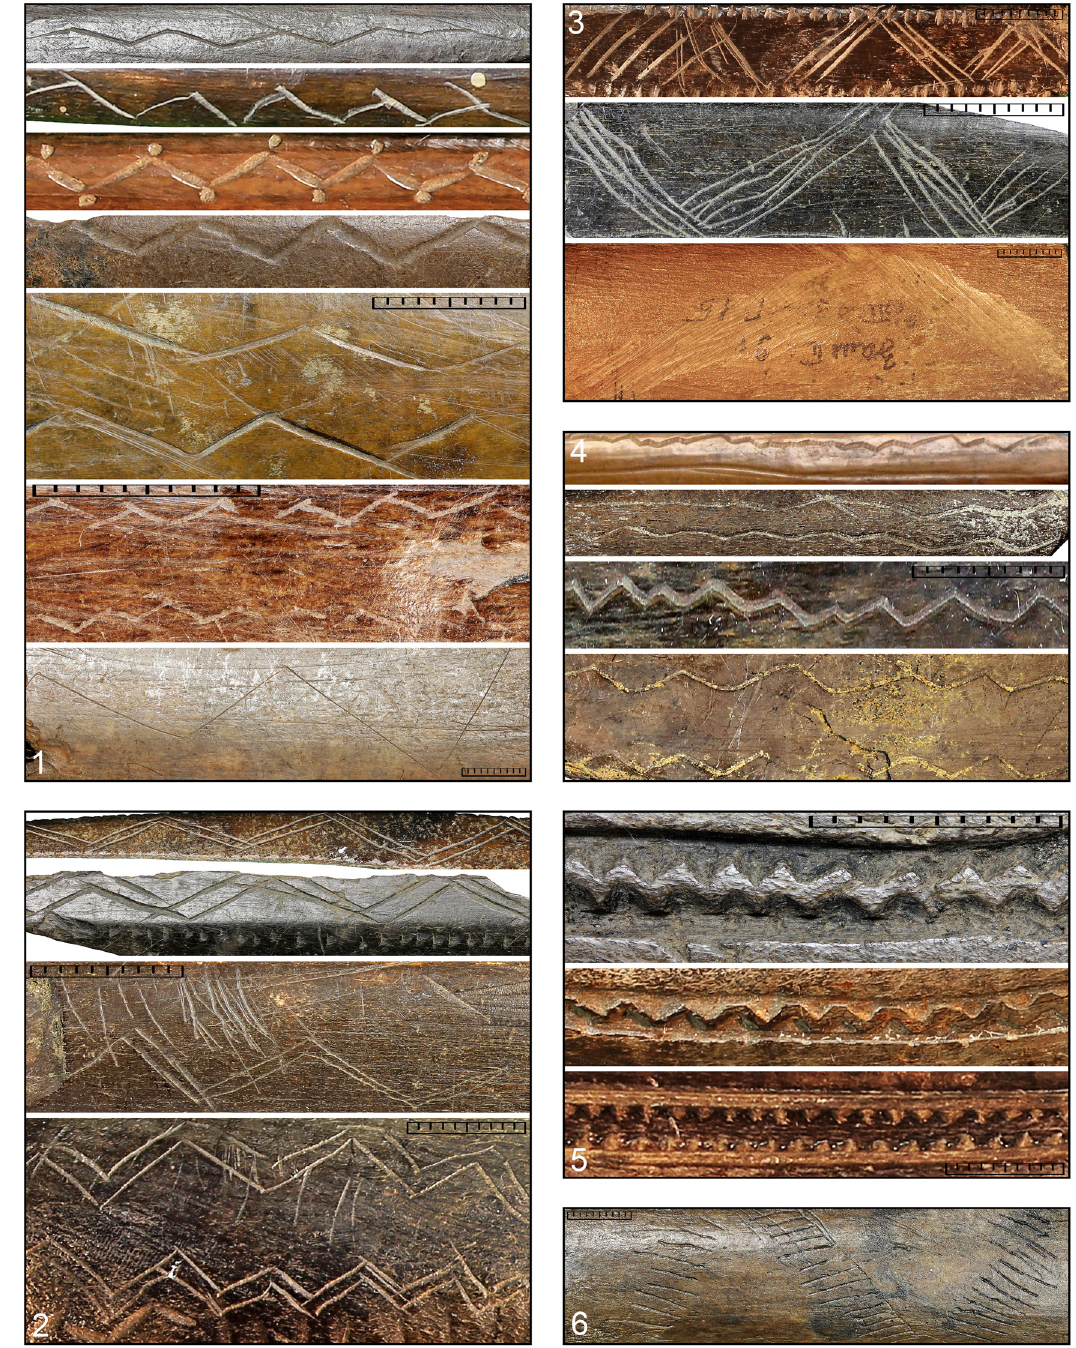
Figure 2: Zamostje 2. Types of zigzag images: ( 1 ) simple zigzag; ( 2 ) double zigzag; ( 3 ) zigzag with three or more parallel lines; ( 4 ) zigzag - shaped lines; ( 5 ) relief zigzag in the groove; ( 6 ) zigzag from other